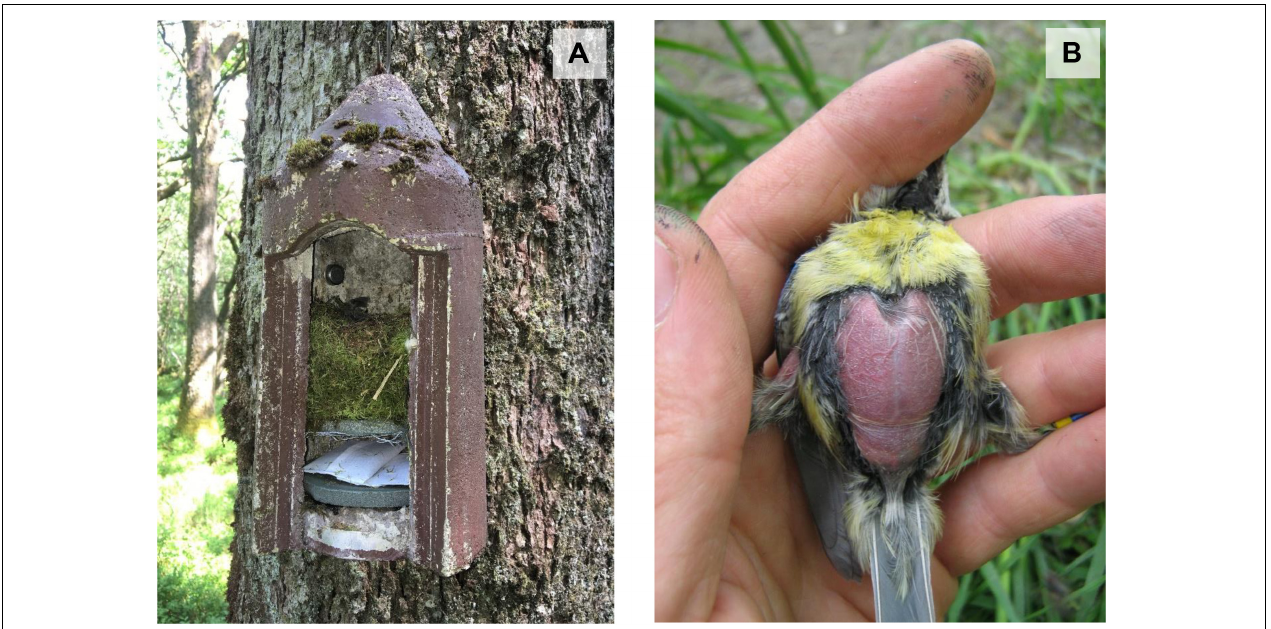
FIGURE 1 | Putative designs for manipulation of heat transfer in nestlings and adults. There is a need for more experimental studies to address the causality of temperature effects on avian reproduction in a warming world. (A) The thermal environment of the nest, at least for hole-nesting species, can easily be manipulated by the addition of a chemical (e.g., hand warmers, as in the figure) or an electrical heating device below the nest. (B) Parental heat transfer can be manipulated by removal of the plumage covering the abdomen and pectoral muscles (the main heat-producing tissue) using small scissors. Future studies should also seek